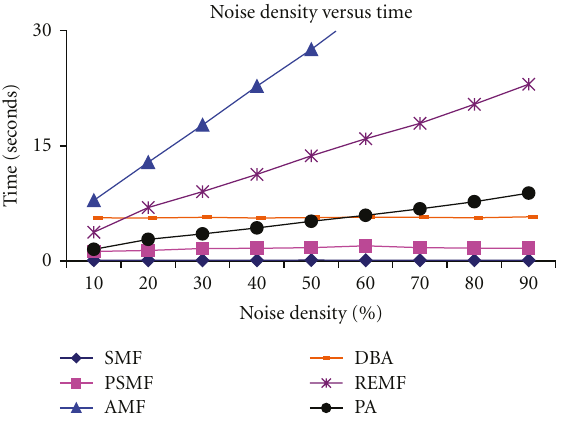
Figure 8: Noise density versus PSNR for cameraman image.